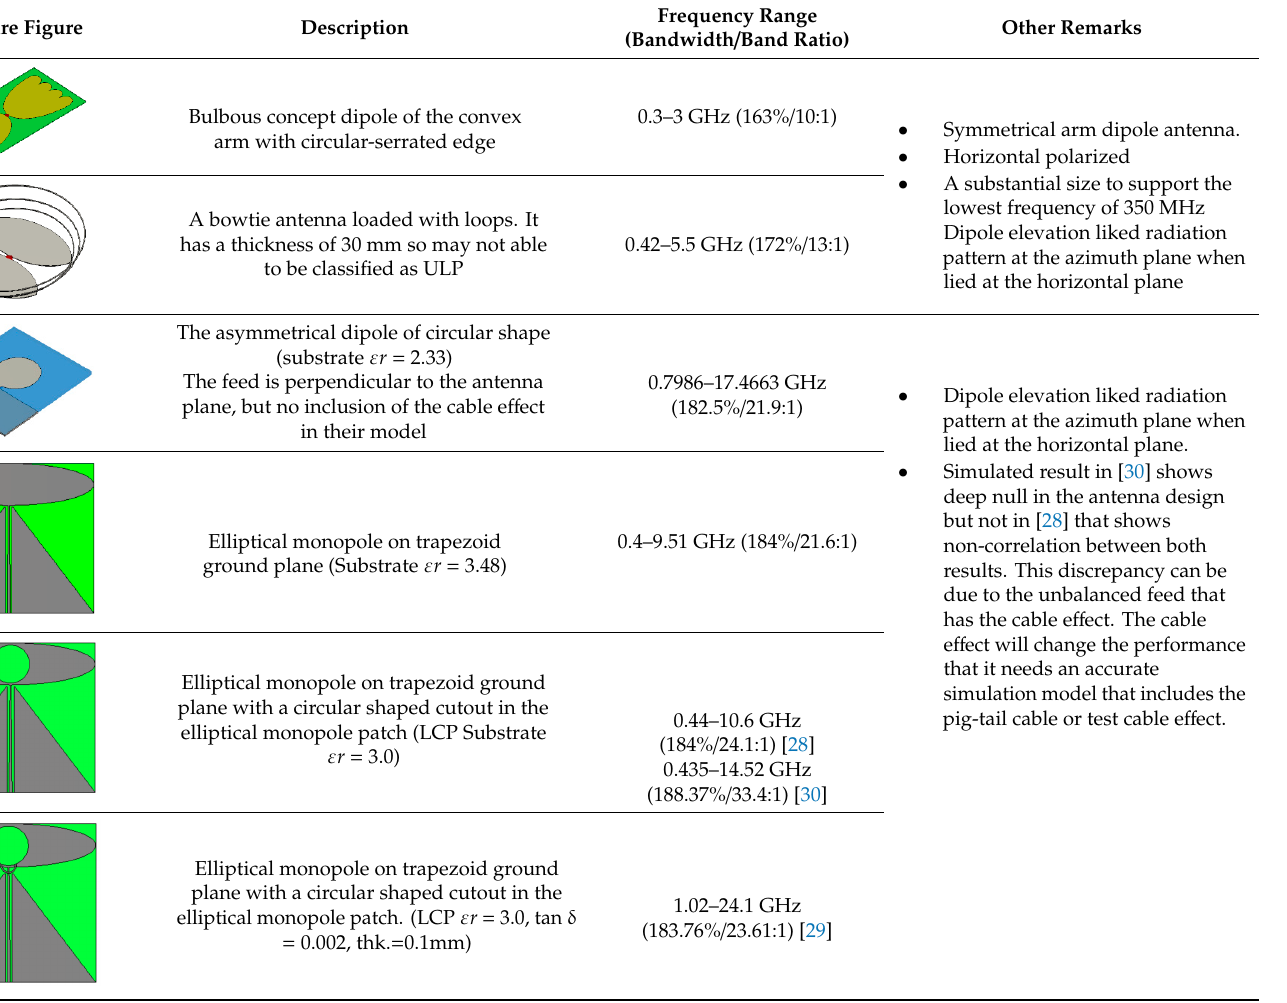
element maximized its electrical length of a circular radome. Notes: 1. The unbalance cable effect of a small antenna varies its performance significant with the cable length of the test cable or jumper cable in the field. Therefore, the proposed antenna includes the 350 mm pigtail cable in simulation model as close as the application as possible to provide a more